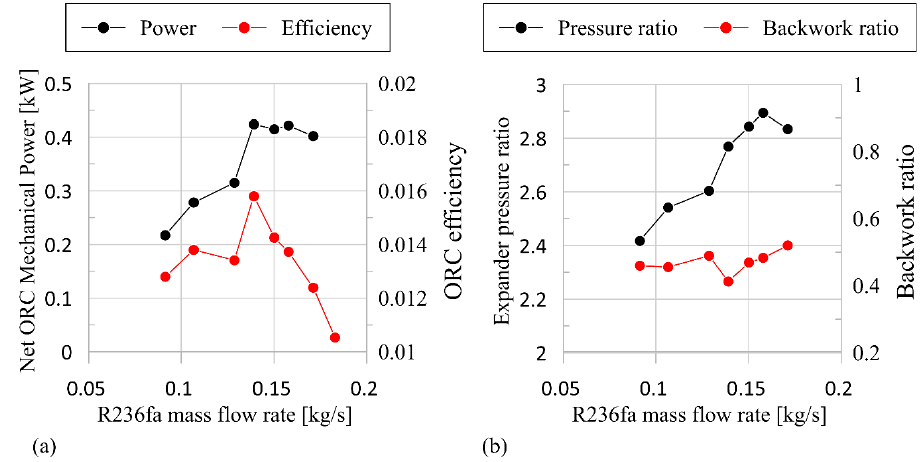
Figure 10. ( a ) Net power produced by ORC and efficiency; and ( b ) expander pressure ratio and backwork